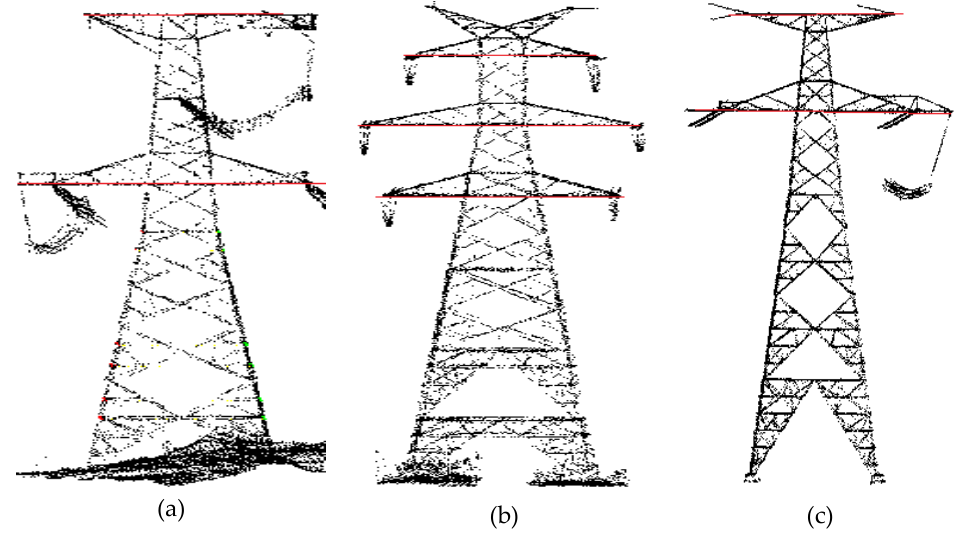
Figure 6. Point cloud and structure of different types of tower. ( a – c ) represent three typical towers